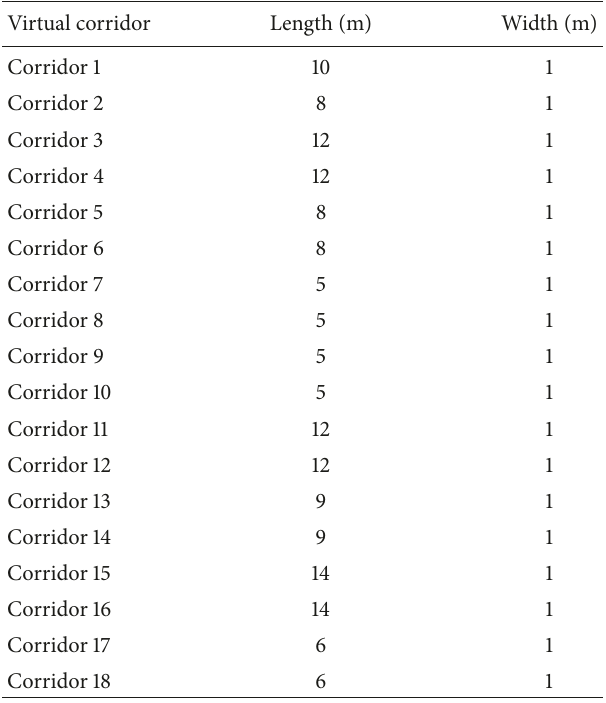
Table 2: Geometric dimensions of the virtual corridors. Table 3: Optimal selection